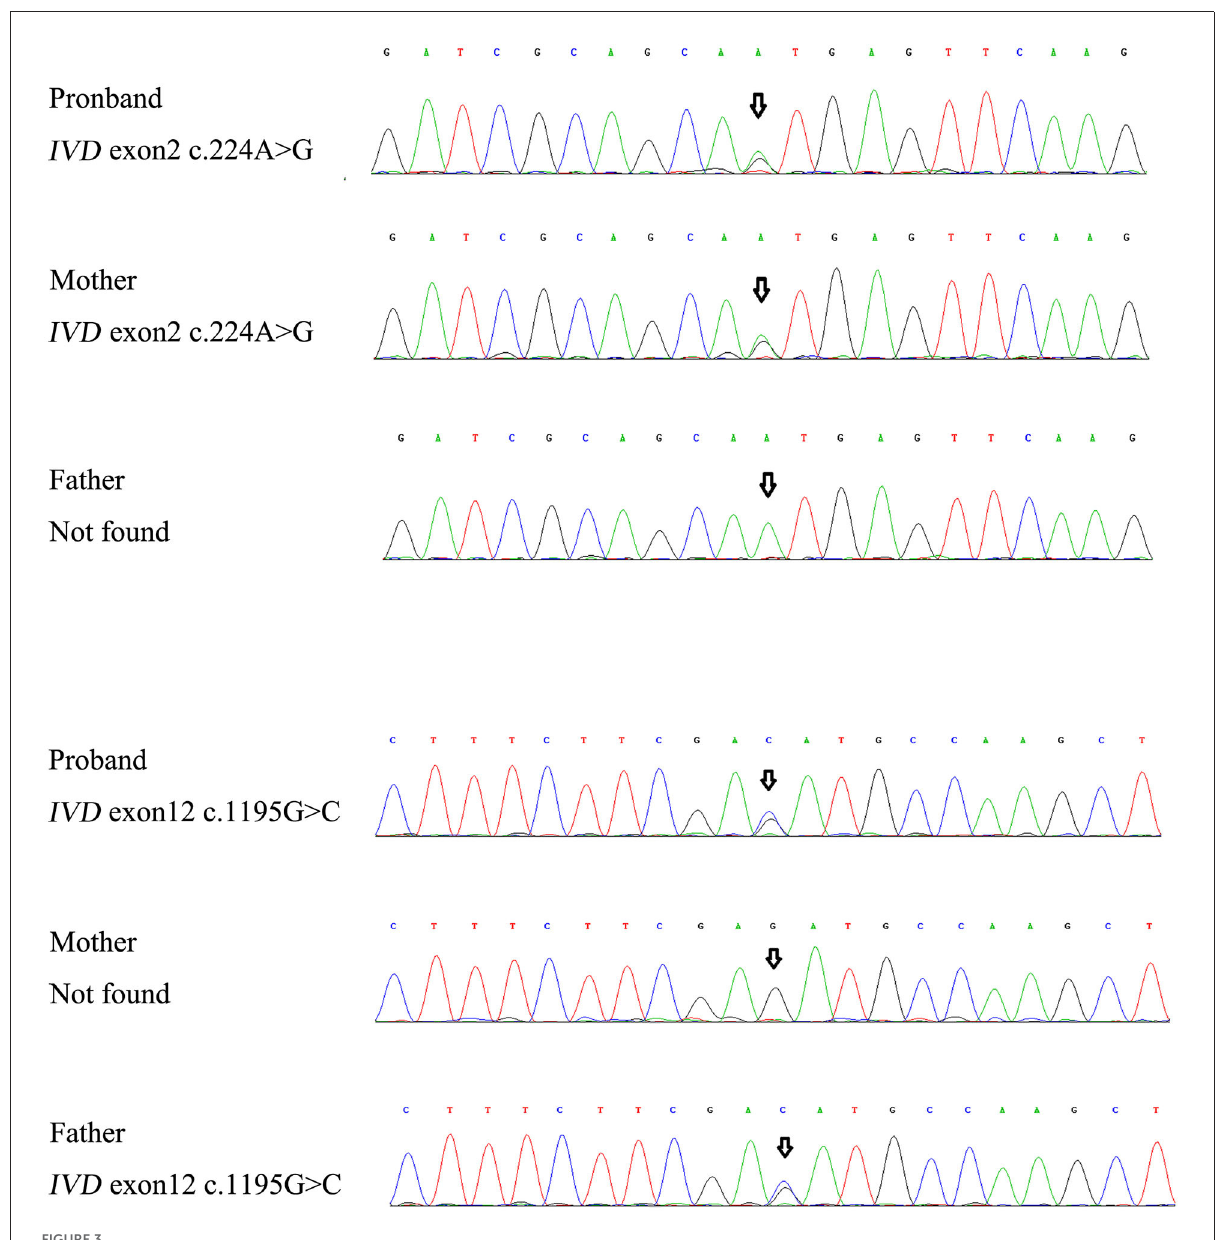
FIGURE3 The gene variations were validated using Sanger